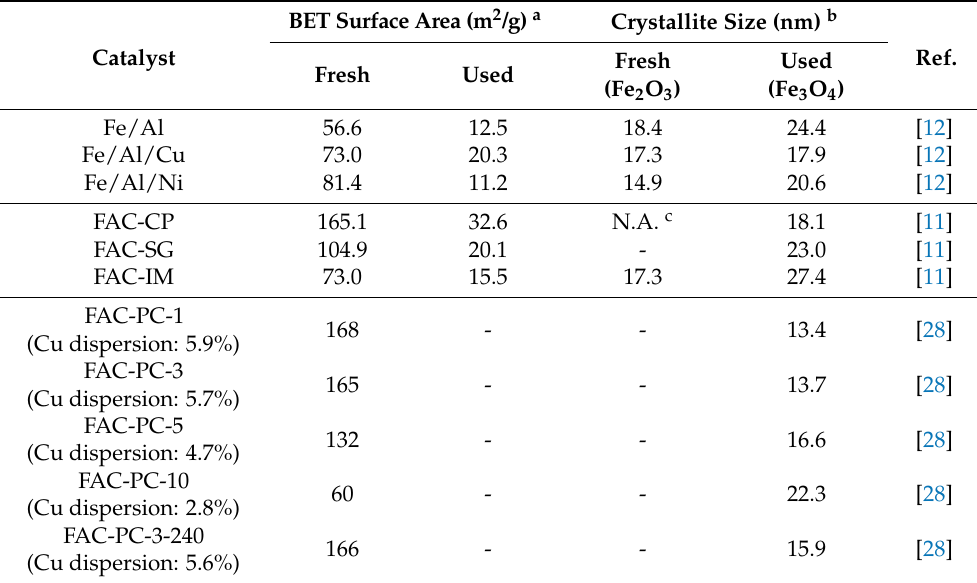
Table 2. Characteristics of Fe-based